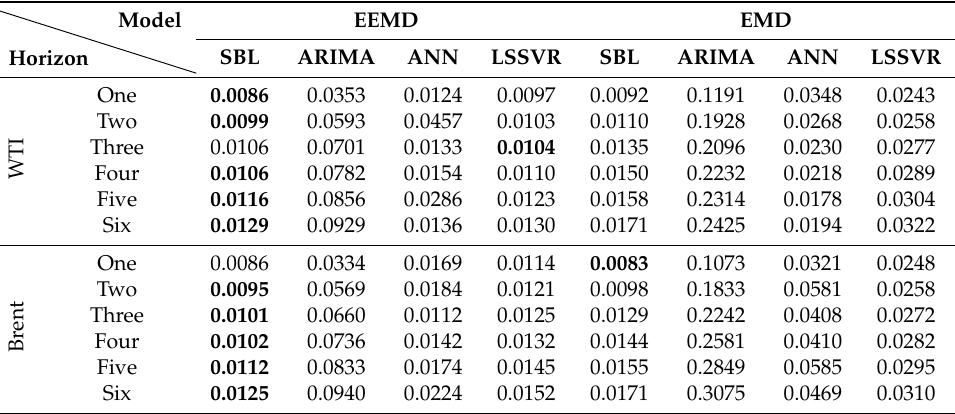
Table 7. The MAPE values by different ensemble models on WTI and Brent crude oil prices. EEMD, ensemble empirical mode decomposition.